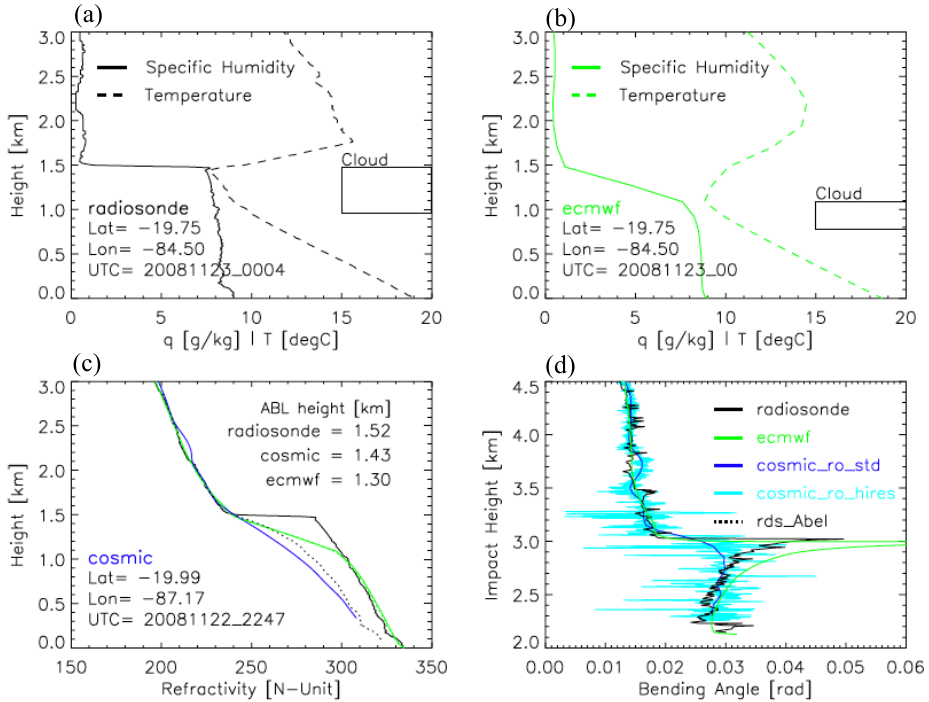
Fig. 2. Typical ABL structure in one VOCALS radiosonde (black) with the near-coincident COSMIC-RO (blue) and ECMWF analysis (green) profiles. (a) Radiosonde specific humidity and temperature; (b) ECMWF analysis specific humidity and temperature; The boxes in (a, b) indicate the cloud region with relative humidity exceeding 94%; (c) refractivity of radiosonde (black), COSMIC RO (blue) and ECMWF analysis (green) as well as simulated refractivity retrieval (black-dotted) based on the simulated radiosonde bending; the ABL heights are listed in the upper right corner, respectively; (d) simulated bending angle of radiosonde (black), ECMWF analysis (green) as well as the standard (blue-solid) and high-resolution (cyan) COSMIC RO bending angles.